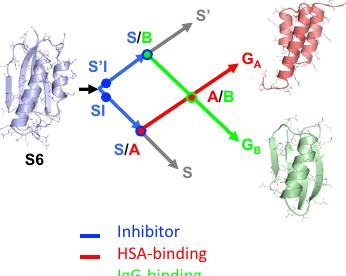
Fig. 1 | Overview of engineered nodes in the S6, G A , and G B networks. S6 is the origin sequence in the engineering process. SI and S ’ I are separate nodes and are loop-size variants of the S-fold, both having protease inhibitor functions. The SI branch of the mutational path leads to a node with the A-fold and HSA binding function.TheS ’ IbranchofthepathleadstoanodewiththeB-foldandIgGbinding function. The S/A node (blue and red circles) includes proteins S a1 , S a2 , A 1 , and A 2 . TheS/Bnode(blueandgreencircle)includesproteinsS b3 ,S b4 ,S b5 ,B 3 ,andB 4 .TheA andBpathsthemselvesintersectatanA/Bnode (greenandredcircles)atwhichA- and B-folds are nearly iso-energetic and bifunctional. The S and S ’ branches con- tinue and connect with many other natural sequences in the α / β plait super-fold